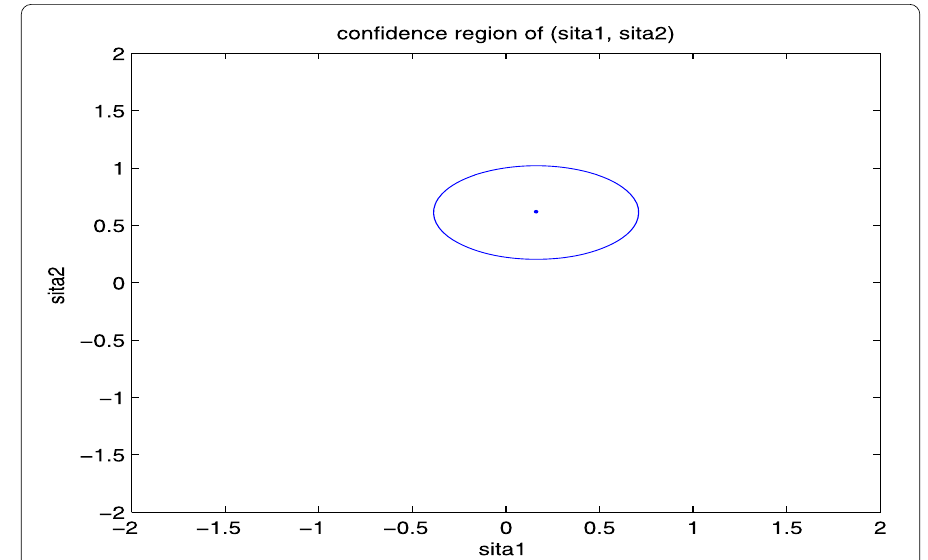
Figure 4 The figure of the empirical likelihood ratio confidence